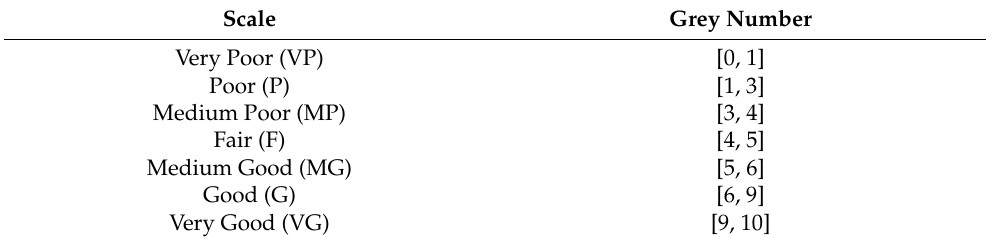
Table 3. The linguistics scale with grey numbers [ x , x ] [68].